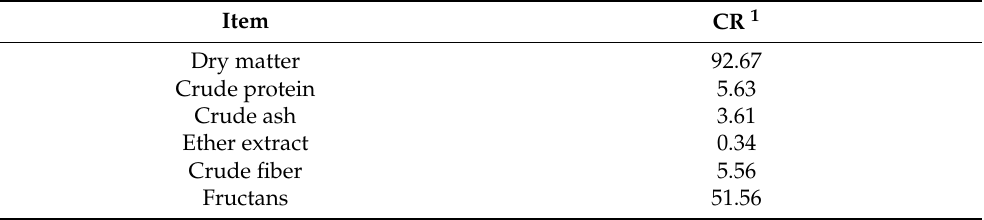
Table 2. Chemical composition (%) of dried chicory root (CR). Item CR 1 Dry matter 92.67 Crude protein 5.63 Crude ash 3.61 Ether extract 0.34 Crude fiber